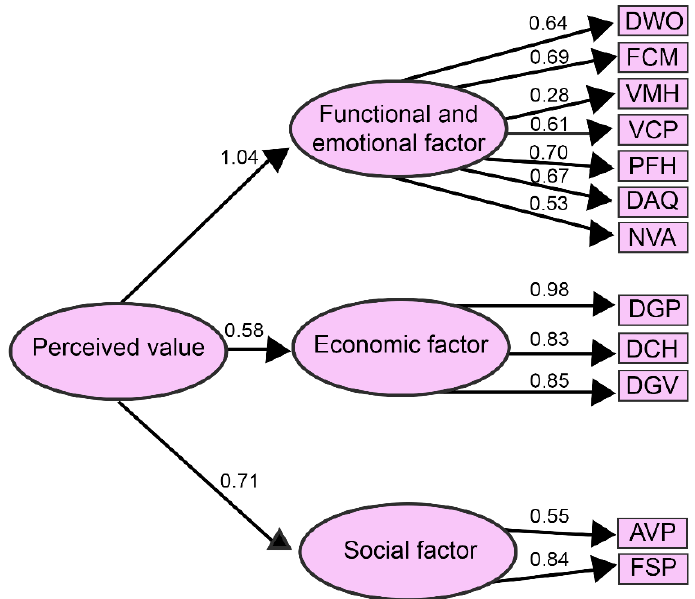
Figure 5. Measurement model: DWO-the destination is well organized, FCM-fate is convenient for me, VMH-this visit makes me feel happy, VCP-this visit is pleasant, PFH-people are friendly and make you feel at home, DAQ-the destination has an adequate level of quality, NVA-the number of visitors the area receives is adequate, DGP-the destination has good prices, DCH-the destination is cheap, DGV-the destination has good value for money, AVP-this destination is visited by many people, FSP-I know I feel like a special person.